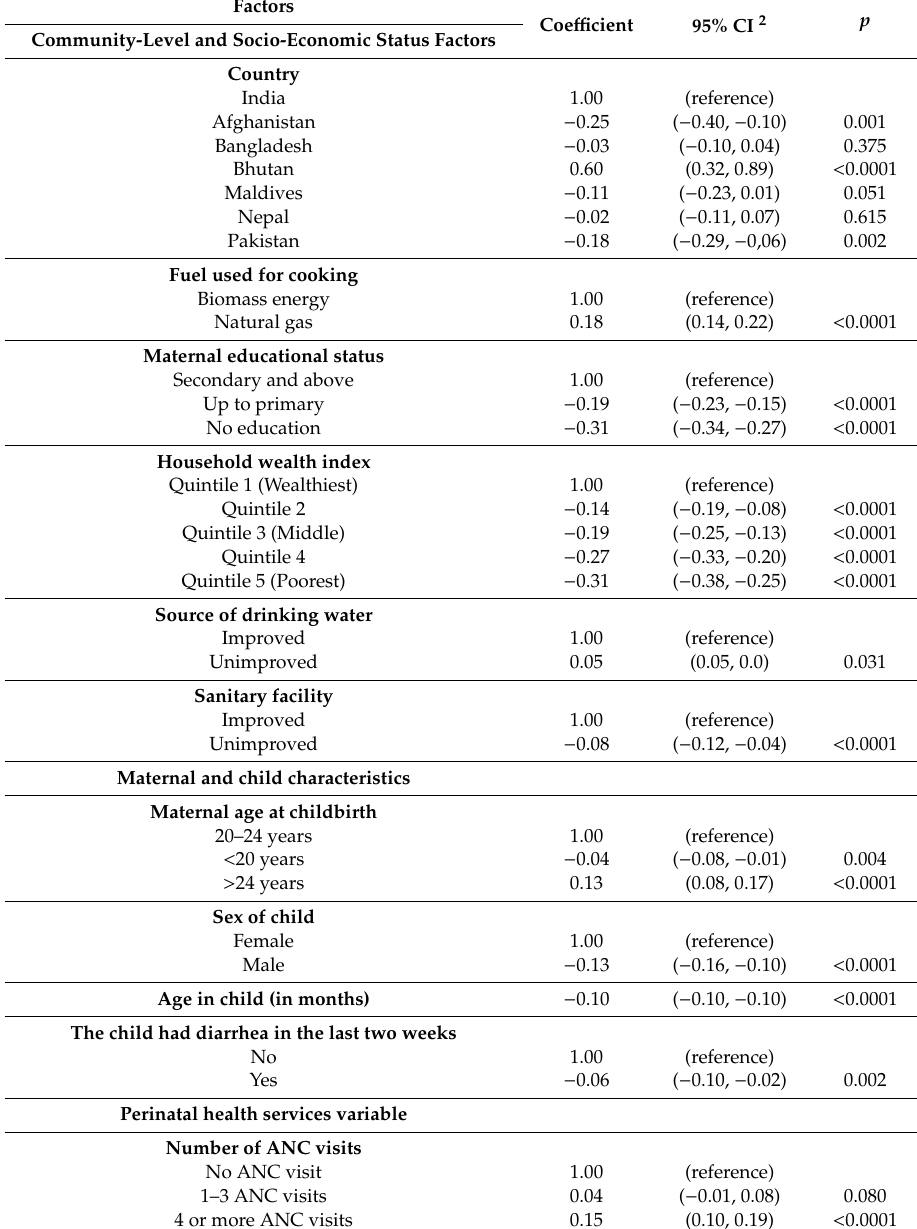
Table 7. Factors associated with length-for-age Z score (LAZ) in South Asian children < 2 years old (2005–2016): Results of adjusted linear regression 1